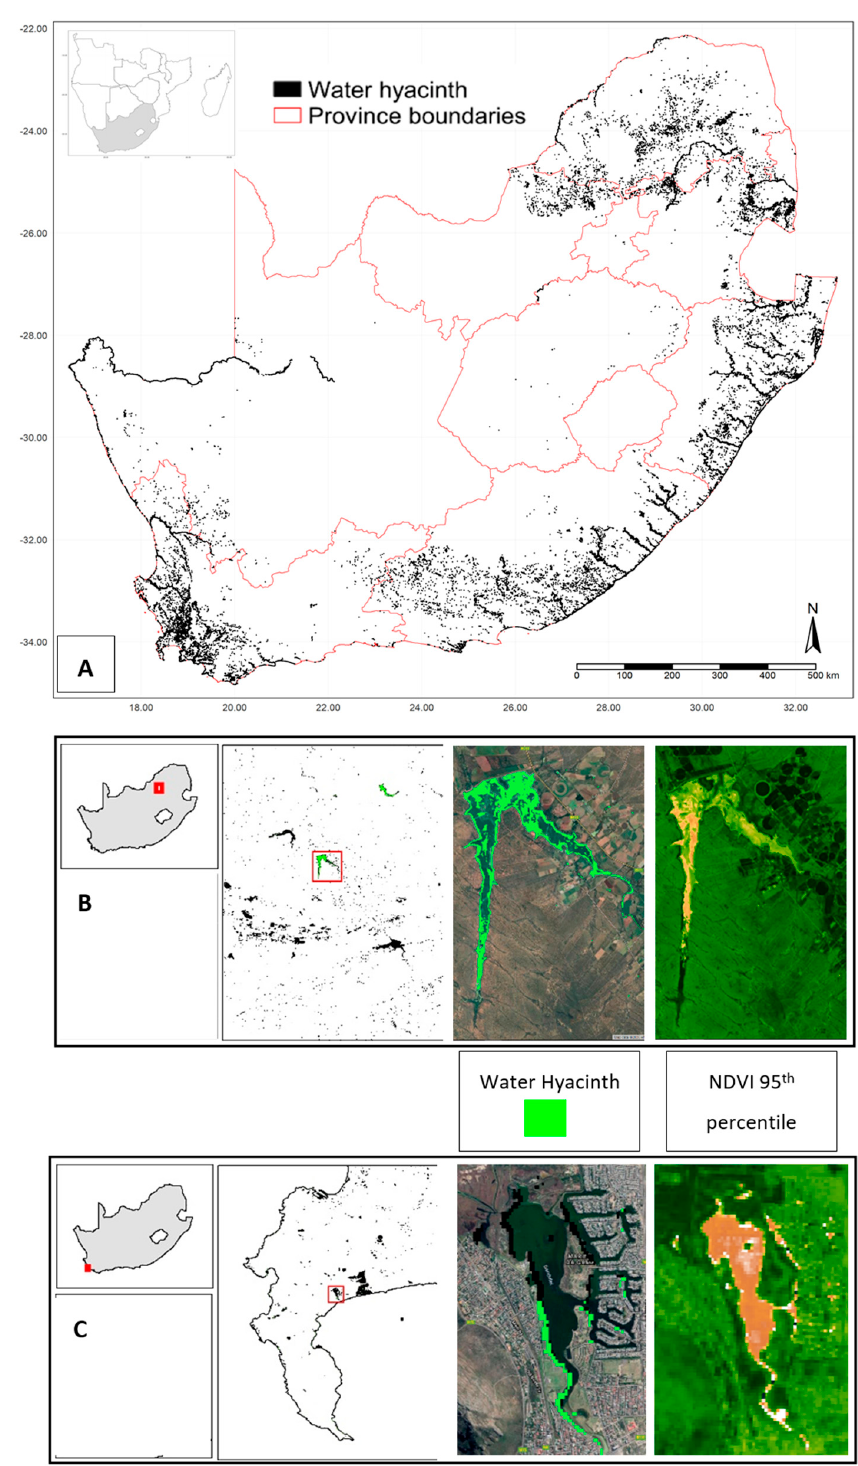
Figure 10. The water hyacinth pixel distribution for 2013 across South Africa ( A ), Roodekoppies dam ( B ) and Sandvlei ( C ) derived from a 95th percentile NDVI Landsat-8 image composite. The area of water hyacinth infestation is 417.74 km 2 or 0.03% of the total area of South Africa. This also corresponds to 2.69% of (permanent and seasonal) surface water within South Africa (15,552.72 km 2 —based on the 2013 annual GSW data). Users may interactively explore this national distribution of water hyacinth here. (script name: 2013 water hyacinth distribution).